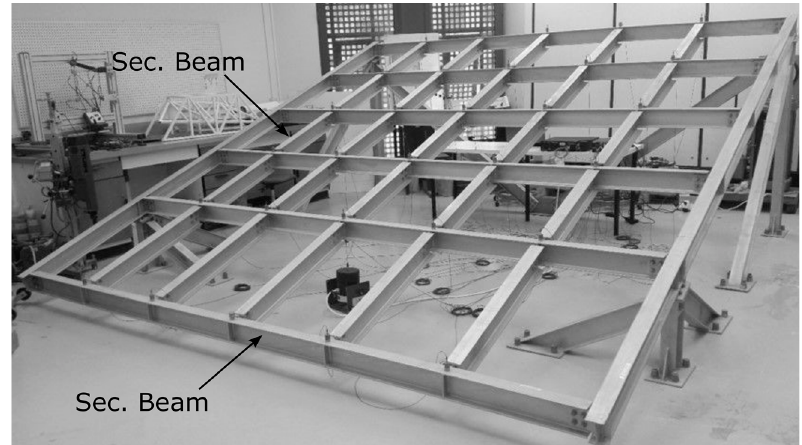
11 of 40 Figure 6. Bridge S101 during testing [145].